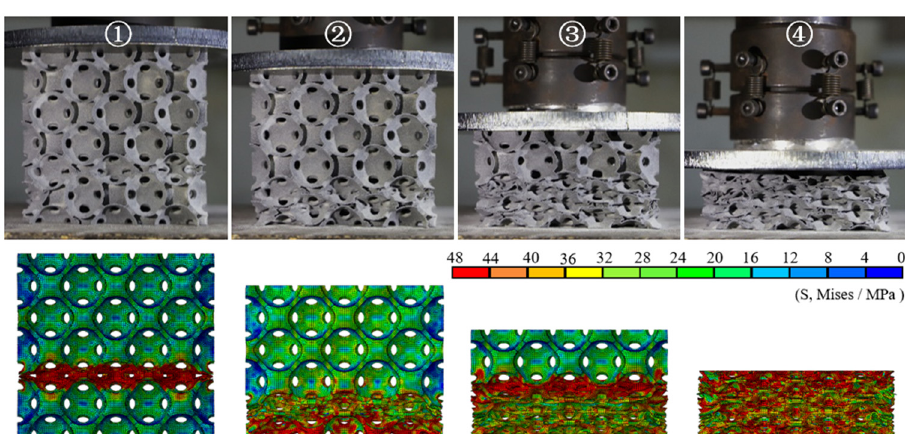
Figure 7. Deformed FCC structures at different stages.